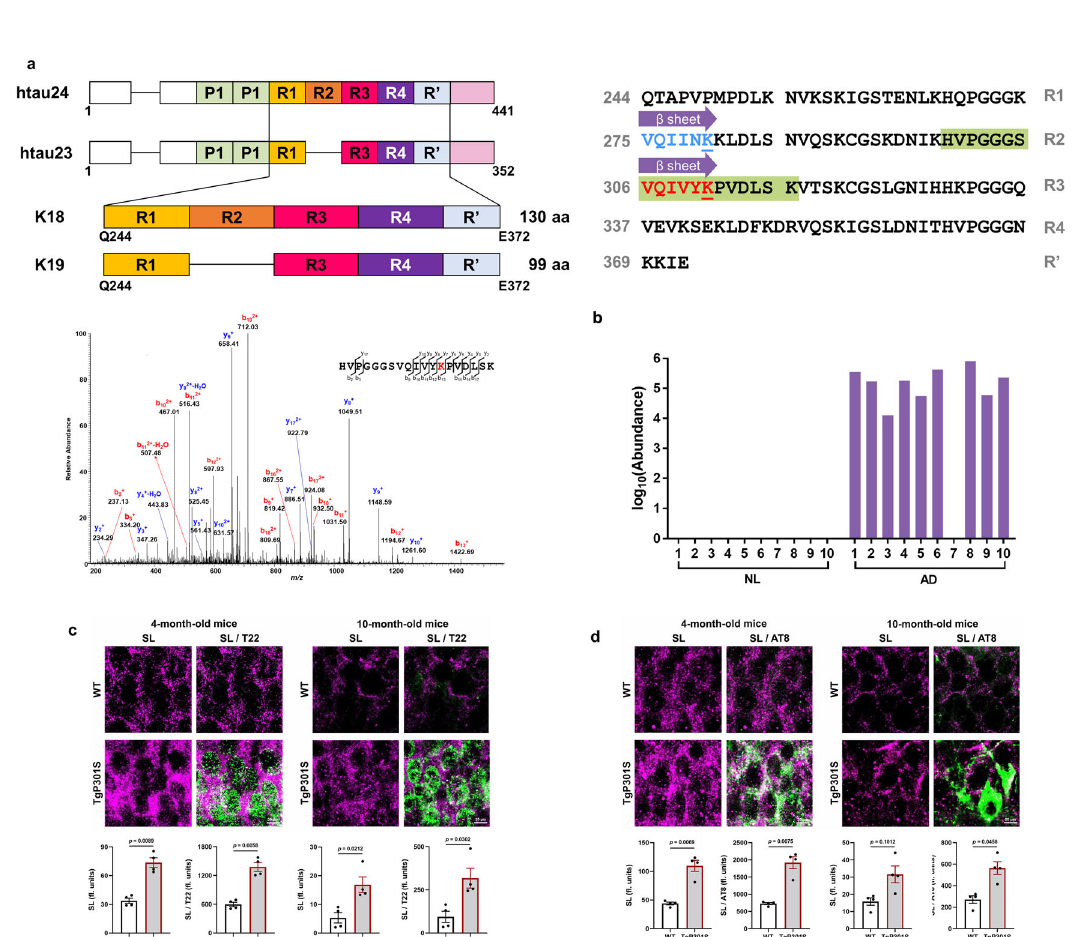
Fig. 6 The unique succinylation of K311 on tau in brains from patients with AD. a Domain structure of tau and the location of succinylation K311. The diagram shows the domain structure of htau23 and 24, which contain three and four repeats, respectively. The constructs K18 and K19 comprise four repeats and three repeats, respectively. Residues are numbered according to tau441 sequence. Purple arrow represents the two central strands of the β - sheet (PHF6*: Val275-Lys280, highlighted in blue, the blue underlined lysine refers to acetylated K280; PHF6: Val306-Lys311, highlighted in red, the red underlined lysine refers to succinylated K311). Green highlights the peptide identi fi ed by MS. MS2 spectrum of m/z 694.0407 3 + leads to con fi dent identi fi cation of a succinylated peptide from tau protein with K311 succinylation site being highlighted in red text. b Abundance of succinylation K311 found in brains from ten controls and ten patients with AD. Data transformed by log 10 (abundance) for normalization purposes and to facilitate presentation. c High-resolution images acquired using confocal laser microscopy display the colocalization of succinylation(magenta) and tau oligomers(green) in the hippocampus of 4-month-old and 10-month-old Tg19959 or WT mice ( n = 4 per each group, two-tailed Student ’ s t -tests). d Fluorescence micrographs obtained from the hippocampus of 4-month-old and 10-month-old Tg19959 or WT mice show the colocalization between succinylation(magenta) and NFTs (green) ( n = 4 per each group, two-tailed Student ’ s t -tests). Source data are provided as a Source Data fi